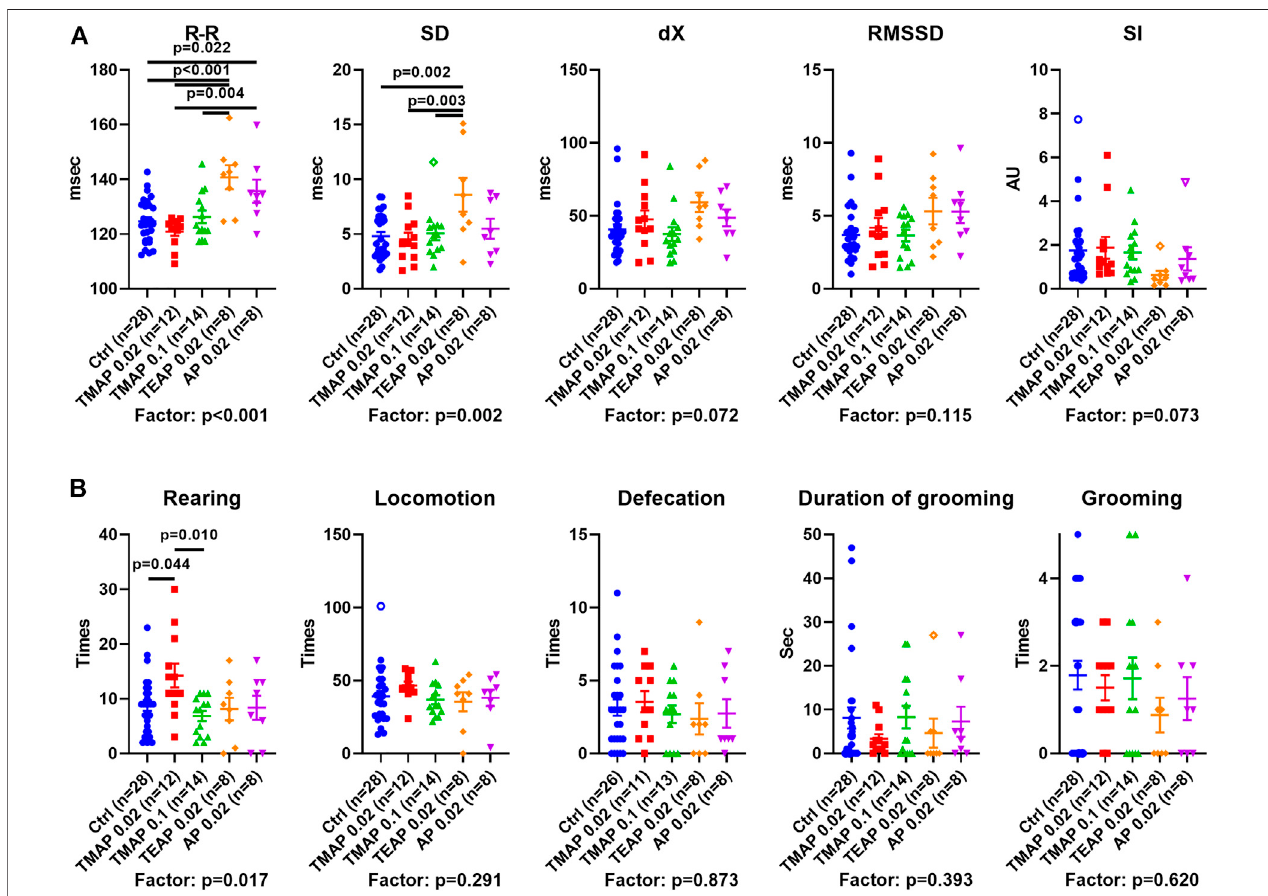
FIGURE 5 | Effects of adipoyl phosphonate (AP), its trimethyl (TMAP), and triethyl (TEAP) esters on physiological parameters. (A) ECG parameters of heart regulation (described in Materials and Methods). (B) Behavioral parameters are determined in the “ open fi eld ” test. Signi fi cant ( p ≤ 0.05) differences between the experimentalgroups,estimatedbyANOVAwithTukey ’ s posthoc test,areindicatedonthegraphs.TheANOVA p -valuesforthetreatmentfactorsigni fi canceareshown below the graphs. Hollow points correspond to outliers according to the iterative Grubb ’ s test, excluded from statistical analysis The number of animals in experimental groups ( n ) is indicated including outliers. AU — arbitrary